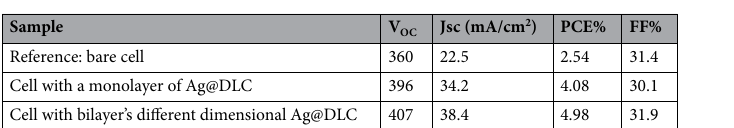
Table 1. Photovoltaic performances of all solar